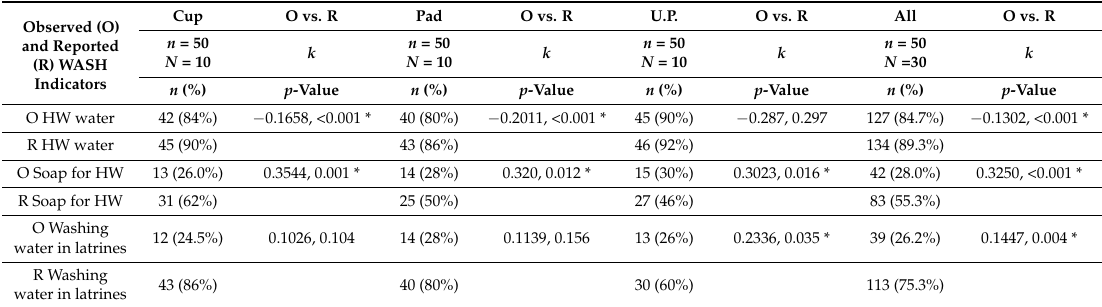
Table 5. Observed vs. Reported water, sanitation, and hygiene (WASH) variables, average across five follow-up rounds, in western Kenya